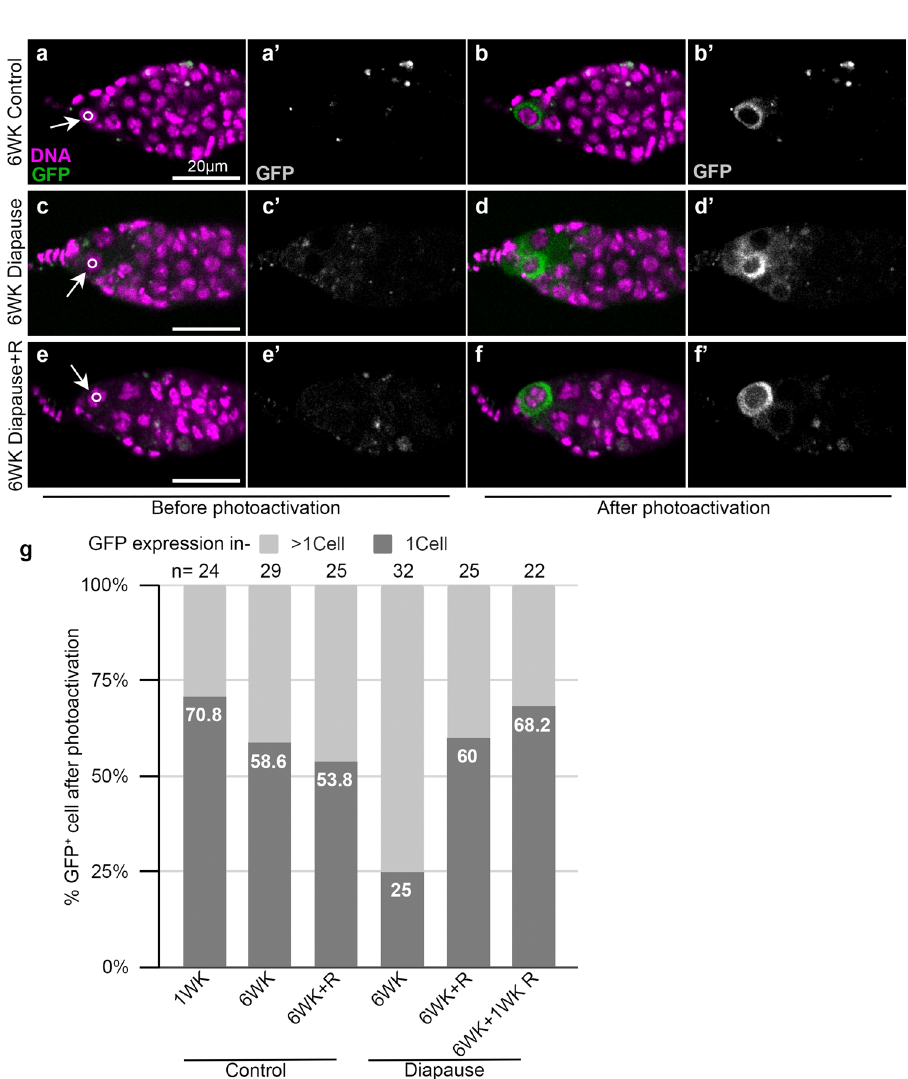
Fig. 7 Incomplete cell division of GSCs in diapause. a – f Confocal micrographs of germaria from nosGAL4>UASp-PA(Photoactivatable)GFP-alphaTub84B fl ies kept at either 25 °C ( a , b and e , f ) or diapause ( c , d ) for the indicated time. Arrows indicate the anteriormost germline cell in each germarium and the circle shows the illuminated area. Images captured before ( a , c , e ) and after ( b , d , f ) photoactivation along with respective grayscale images are displayed ( a ’ – f ’ ). g Quanti fi cation of GFP con fi ned to a single cell (1 cell) or to multiple cells (>1 cell). n , the numbers of photoactivation experiments carried out are shown above the bar. See also Supplementary Fig. 7.